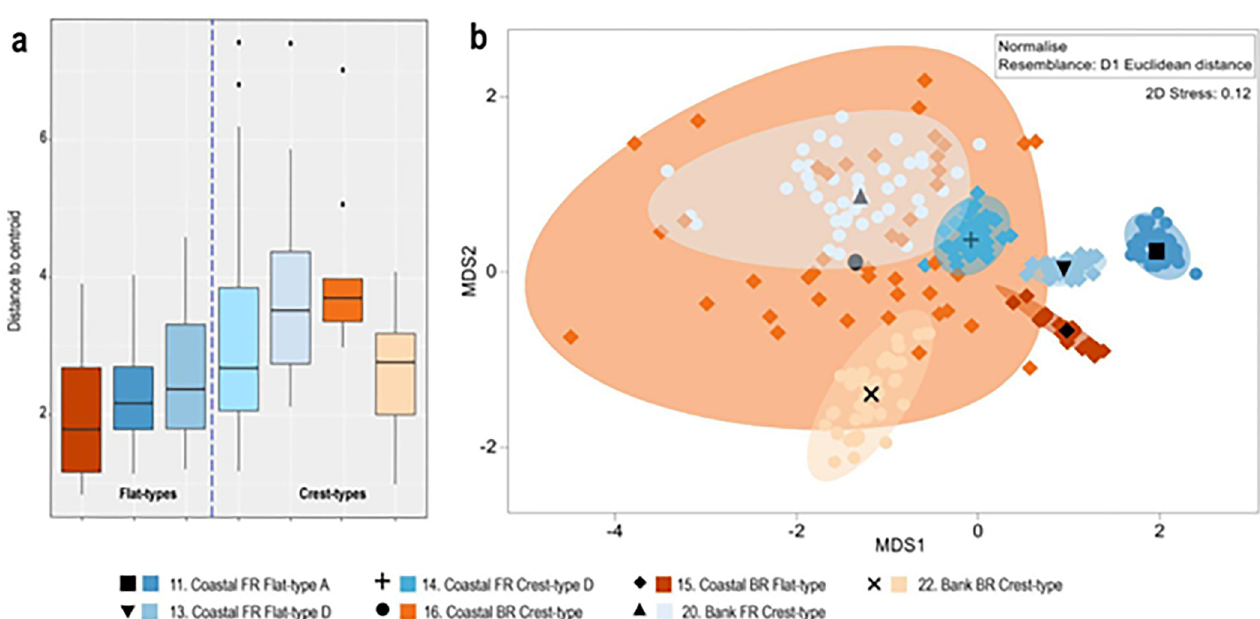
Fig 5. Multivariate analysis of dispersion and central tendencies of morphometrics in the seven common reef subtypes. a: Boxplot of multivariate dispersion (variance), showing the median and interquartile ranges of distances to the group centroid. Note: dashed line divides flat and crest subtypes, and crest types have outliers in 3 of the 4 groups. b. Multivariate Central Tendency of morphometrics. The mMDS plot shows bootstraps averages together with 95% region estimates of uncertainty for ‘mean settings’ (black symbols) of each reef subtype. Bootstrapping approximation is obtained from the distances in an m = 5-dimensional mMDS space, for which the Pearson correlation to the dissimilarities is = 0.993. The overlapping diffuse subtypes (14, 16, 20, 22), with a high average squared Euclidean distance, indicate higher uncertainty in the central tendency (implying indistinct morphologies) compared to the 3 other subtypes (11, 13, 15) where the uncertainty in central tendency is considerably lower (implying distinct